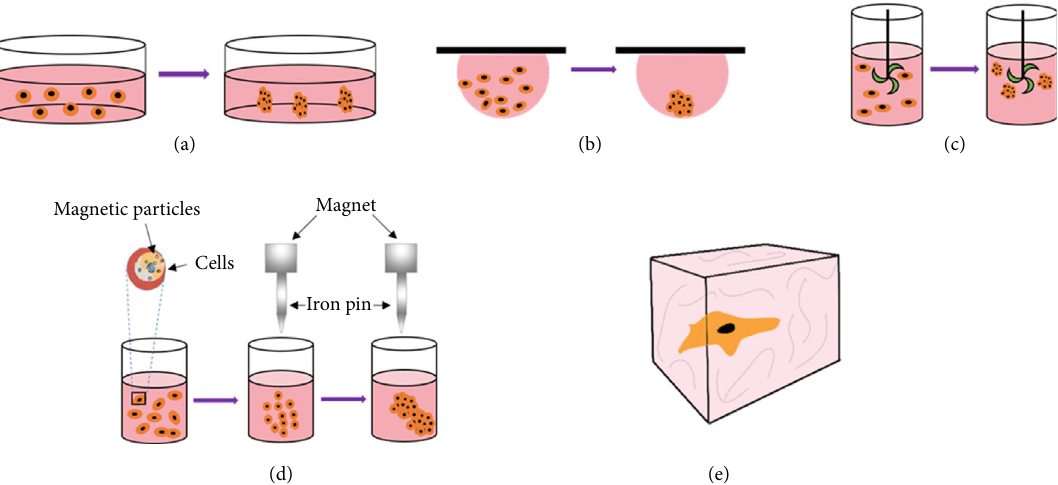
Figure 1: Scheme of 3D cell culture systems: (a) liquid overlay culture; (b) hanging drop culture; (c) rotating bioreactor culture; (d) magnetic suspension culture; (e) sca ff old-based culture